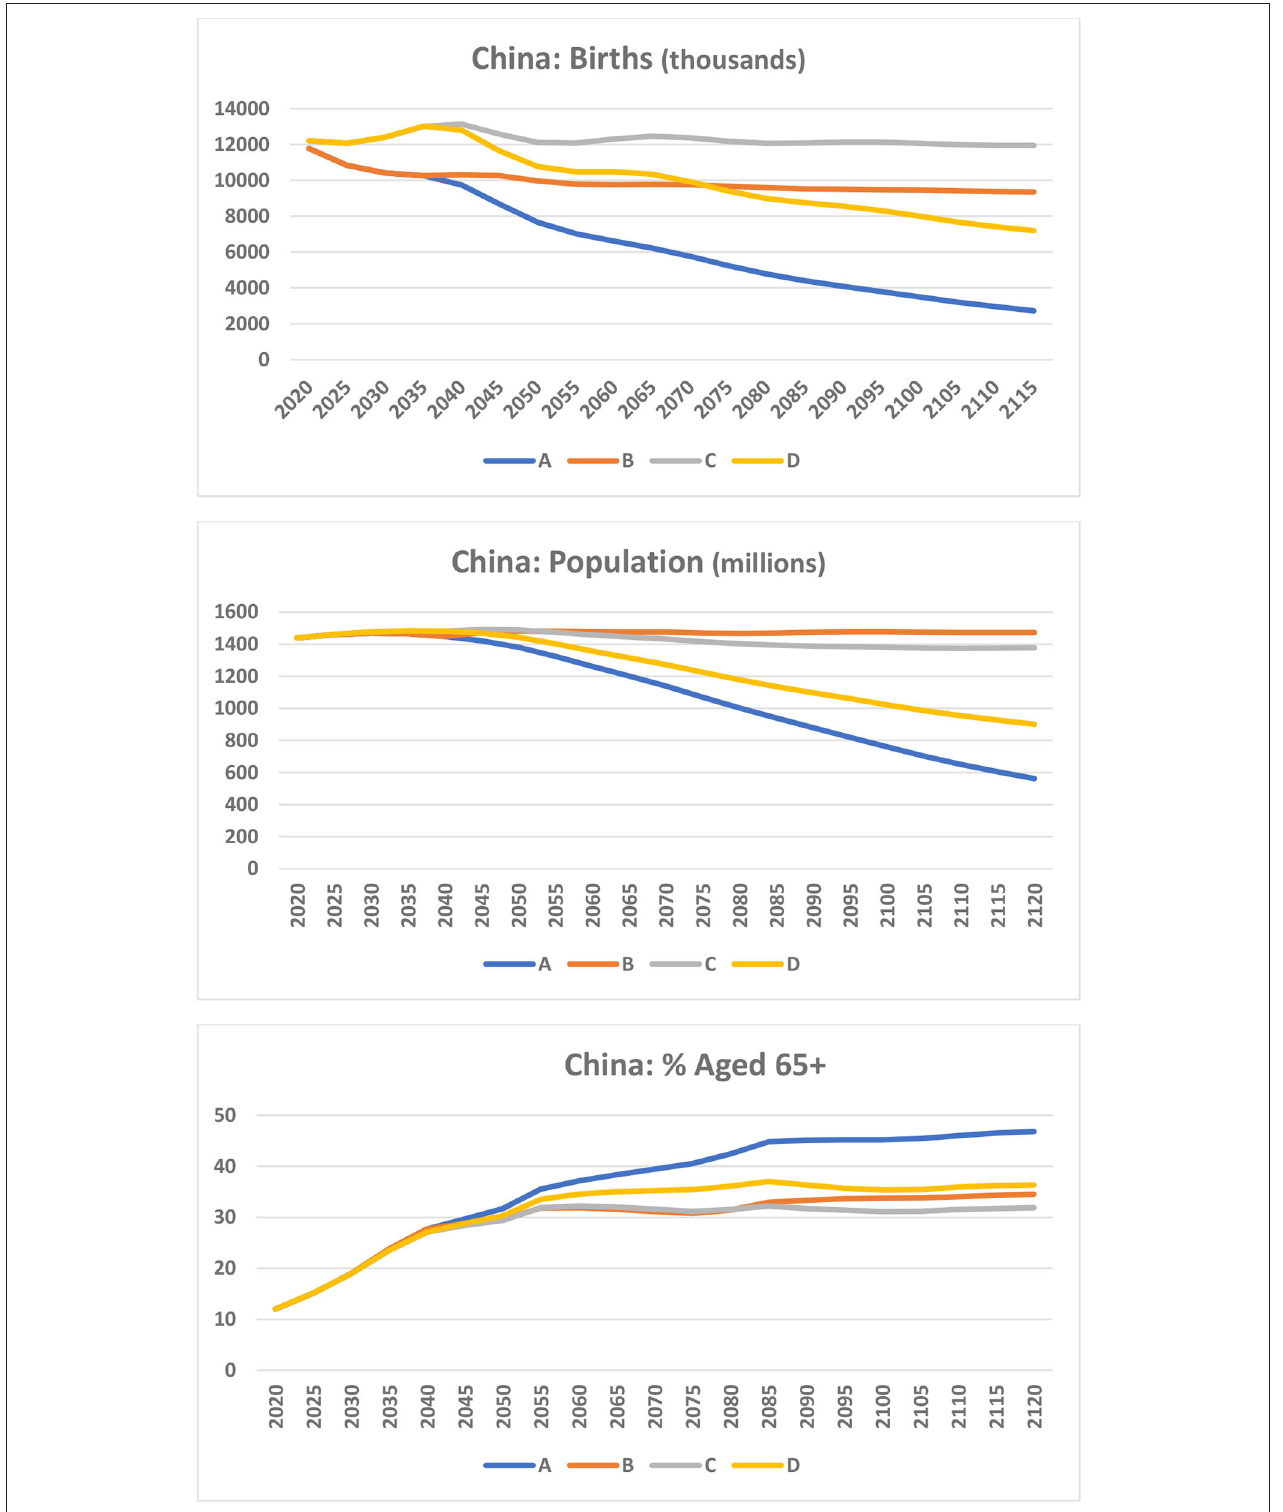
FIGURE 3 | China: Projections of births, population and percent of population aged 65 + . A: TFR = 1.3; Net migration = 0. B: TFR = 1.3; Net migration = 9 million from 2040. C: TFR rises from 1.3 in 2020 to 1.7 in 2040; Net migration = 4 million from 2040. D: TFR rises from 1.3 in 2020 to 1.7 in 2040; Net Migration = 0.